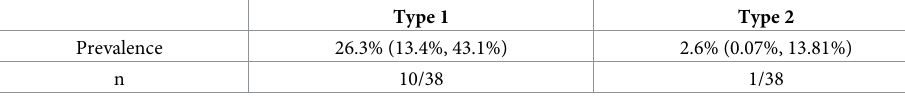
Table 2. Prevalence of peripheral pulmonary vascular abnormalities.